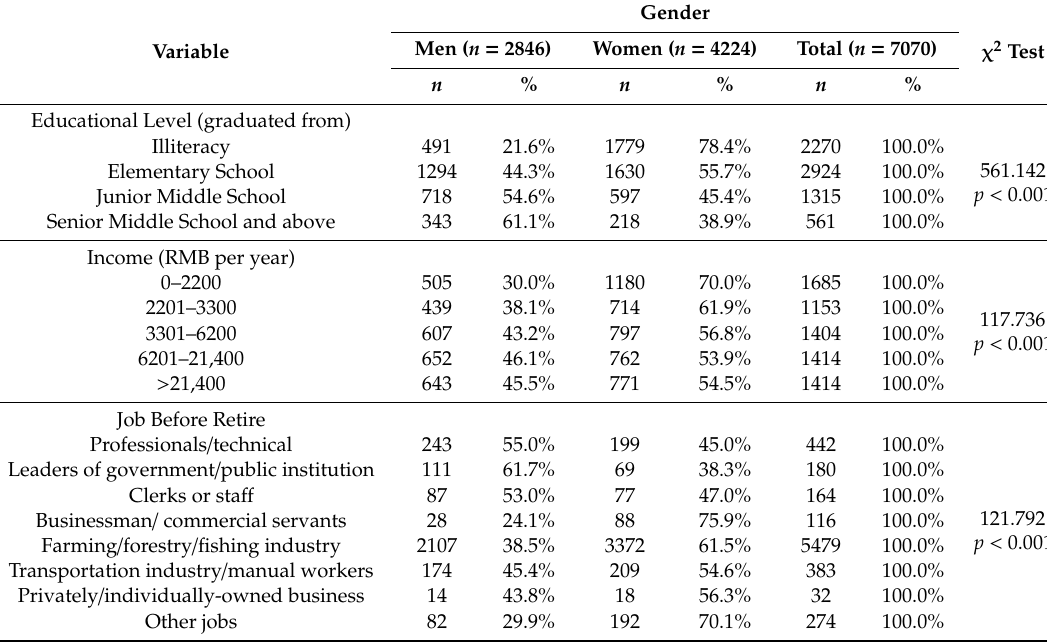
Table 3. Descriptive Characteristic of Participants by